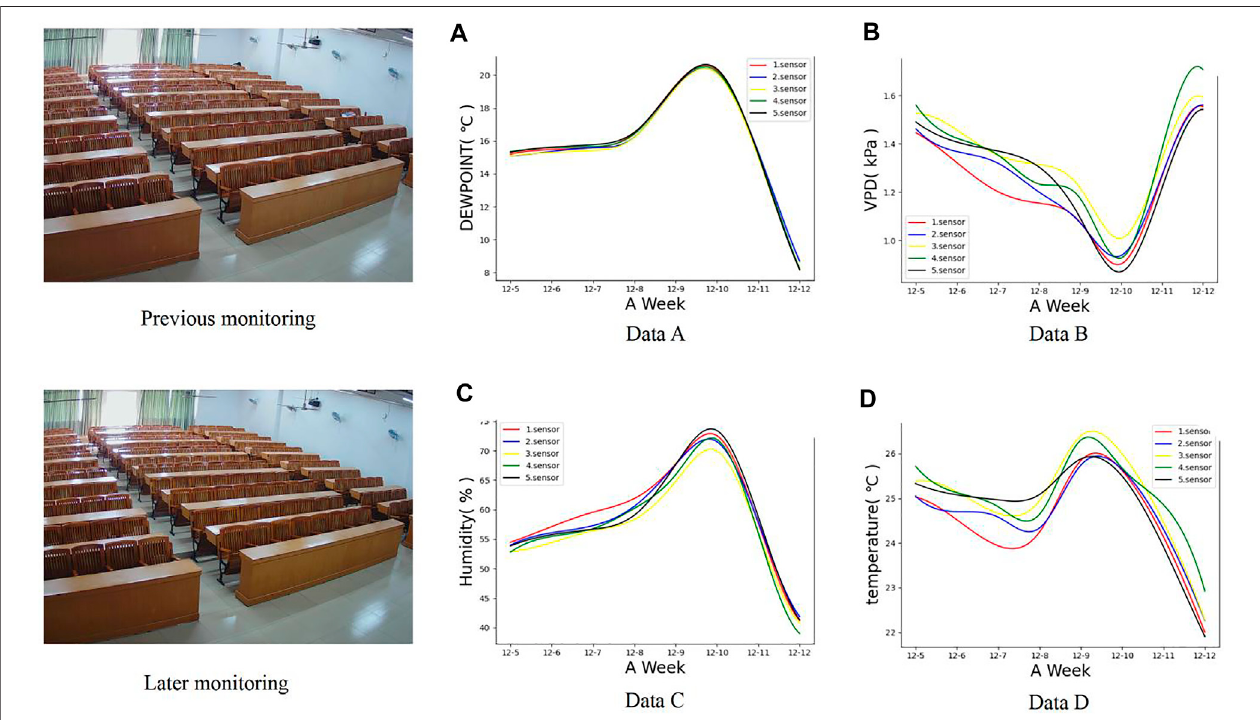
FIGURE 2 | The fi gure is a visualization of the data, the left area is the monitoring image, and the right area is the data collected by the sensor, namely dewpoint ( ° C),VPD(kPa), humidity (%) and temperature ( ° C).